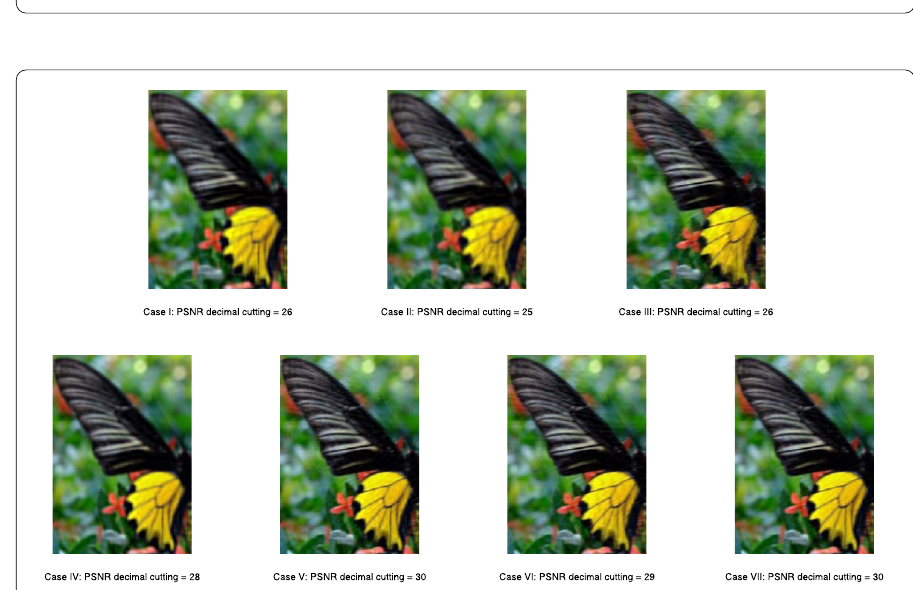
Figure 3 The reconstructed RGB image with its PSNR (decimal cutting) for all cases with the PVTSE algorithm being used, after 500